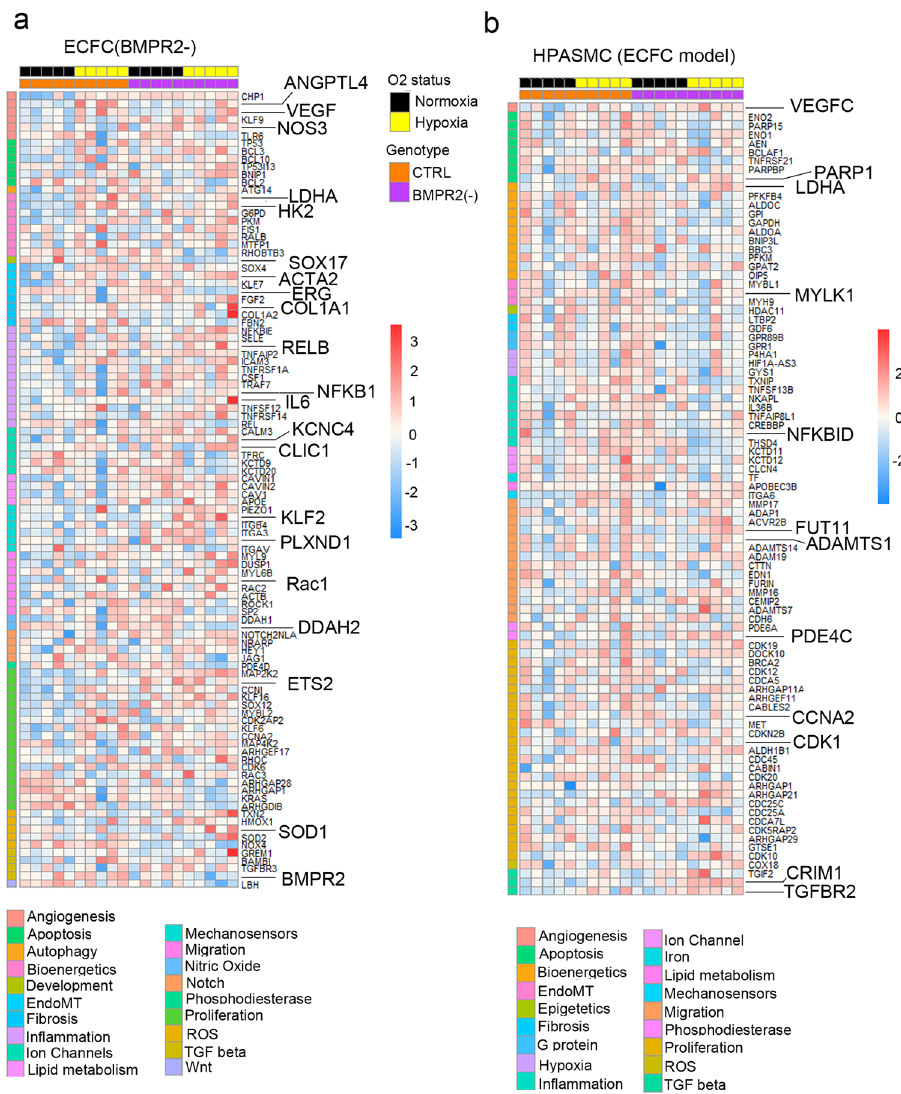
Fig. 5 Disease pathways in control and patient-derived ECFC datasets. Top DEG associated with cardiovascular diseases were grouped into categories and visualised as TPM heatmaps. Colour-coded pathways are shown underneath the heatmaps, with key gene symbols enlarged in a PAH ECFCs and b HPASMCs co-cultured with ECFCs. The genotype status (control and BMPR2 knockdown) and oxygen status (normoxia or hypoxia) are shown at the top of the heatmap in different colours, as indicated. Changes in gene expression are also colour coded, with blue denoting a lower relative gene expression and red denoting a higher relative gene expression. Each column represents 1 donor; n = 5 different biological donors/treatment